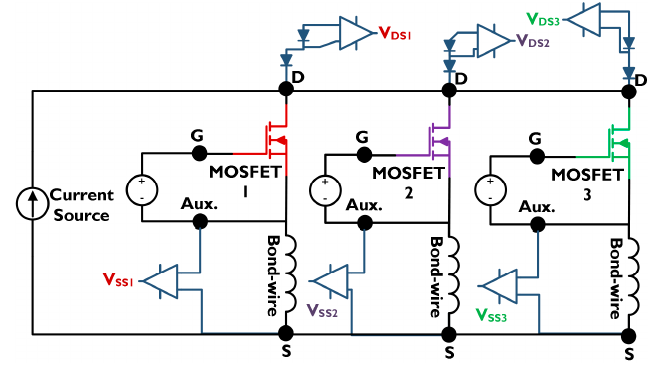
Figure 5. Setup for Power Cycling Test of three SiC MOSFETs.